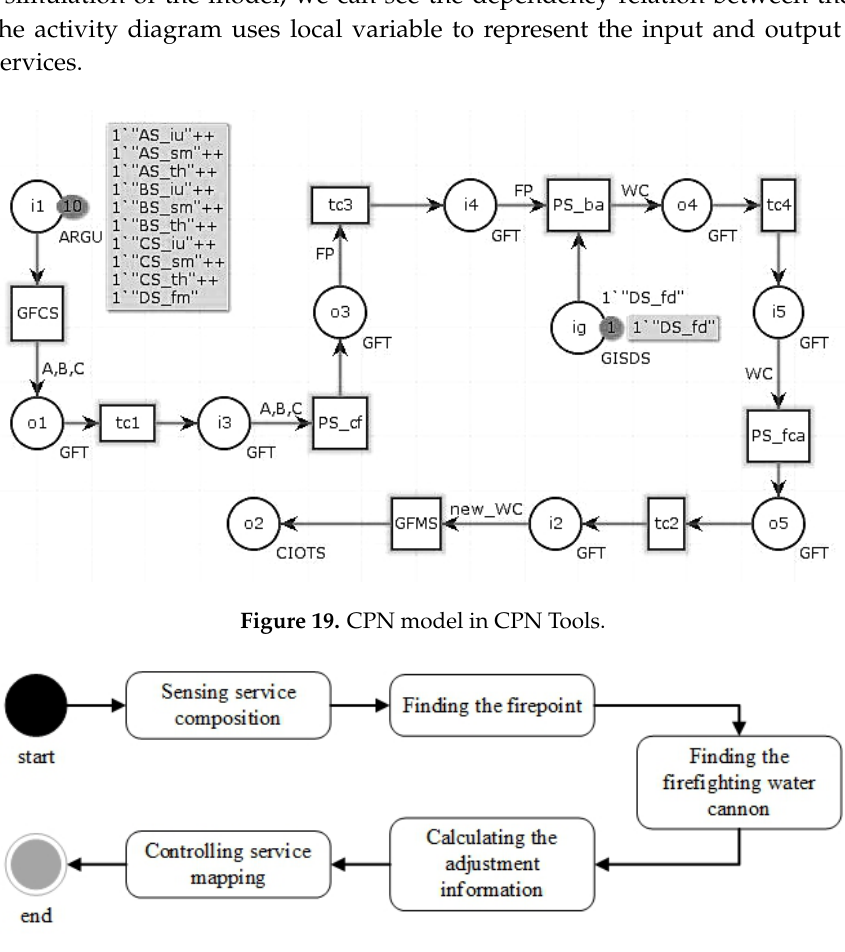
Figure 20. Activity diagram for service